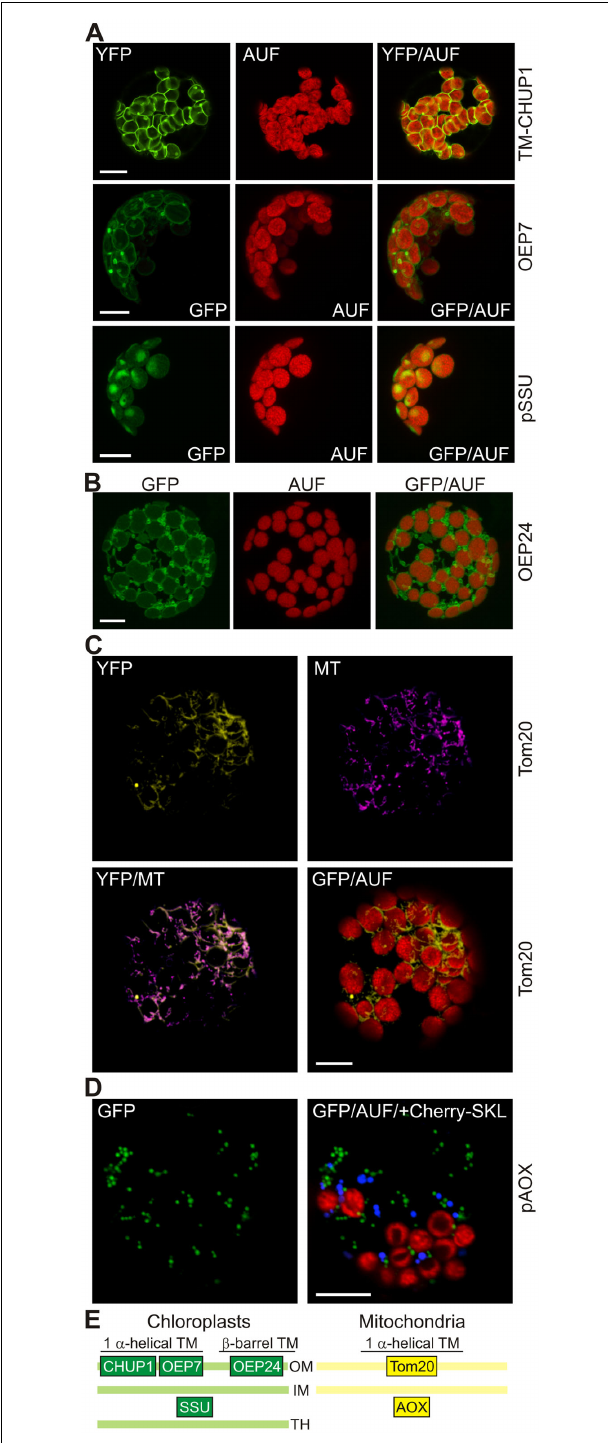
FIGURE 1 | High expression levels of outer membrane proteins lead to changes in chloroplast and mitochondrial membrane morphology. (A) The transmembrane (TM) domain of the chloroplast outer envelope protein CHUP1, full length outer envelope protein 7 (OEP7), or the small subunit of RUBISCO (pSSU) were fused to the N-terminus of GFP and